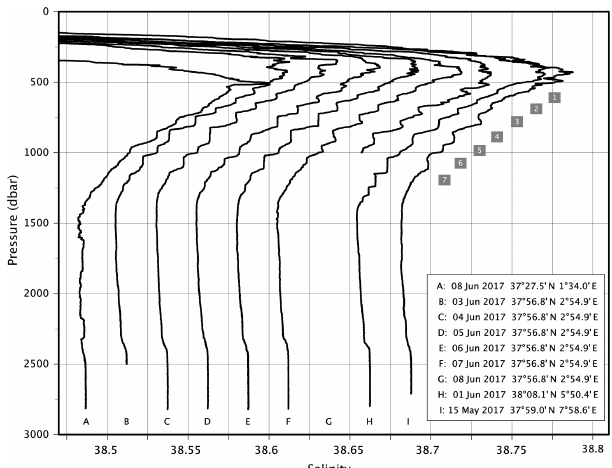
Figure 7. Sequence of salinity profiles along a zonal transect with four stations across the Algerian Basin during the PEACETIME cruise. The second station was repeated six times (casts B–G). The casts were performed from the surface to the bottom, except cast B (down to 2500dbar) and cast G (down to 1000dbar). The salinity scale is correct for profile A, and each subsequent profile is offset by 0.025. The layer numbering of Table 4 is indicated by grey boxes at the average layer